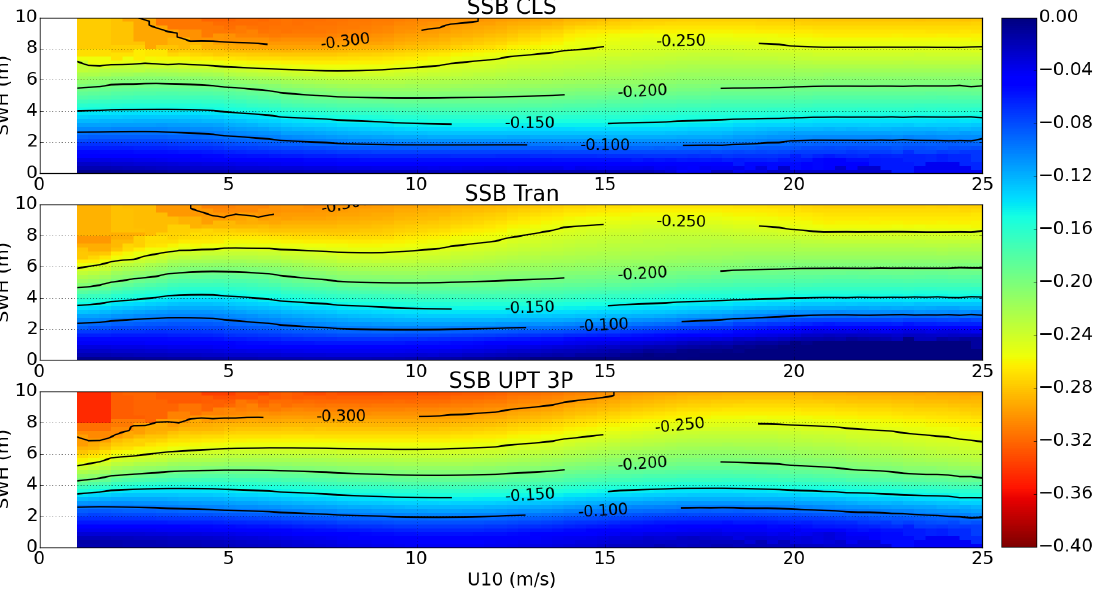
Figure 6. SSB performances for a testing dataset ranging between Jason-1 cycles 150-260 in SWH-U10 domain. From top to bottom, SSB CLS approach using the two classic predictors (SWH and U10), SSB Tran modulation using the same previous predictors, but adding the extra mean wave period information derived from WW3, and the proposed model design SSB_UPT_3P with TzG03 acting as a mediator parameter, interacting with SWH and